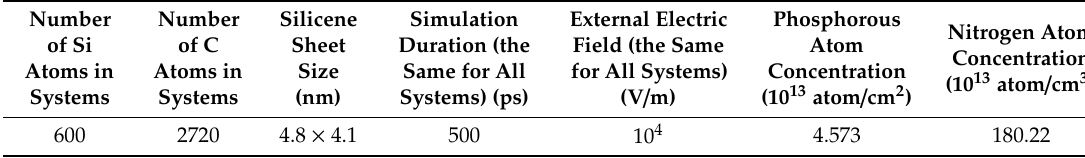
Table 4. Initial parameters used in the